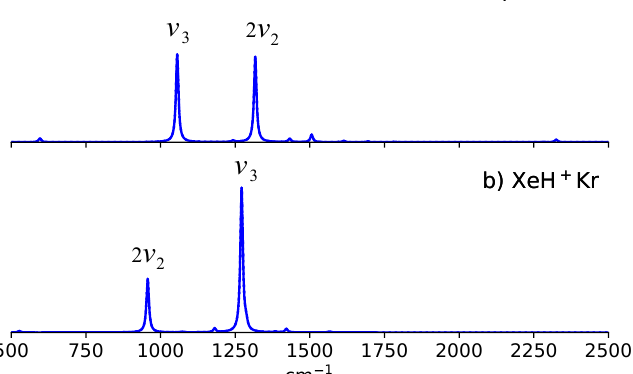
Figure 3. Fermi resonance bands between 2 ν 2 and ν 3 for ( a ) ArH + Kr and ( b ) XeH + Kr. Adapted with permission from Ref. [60]. Copyright 2021 AIP